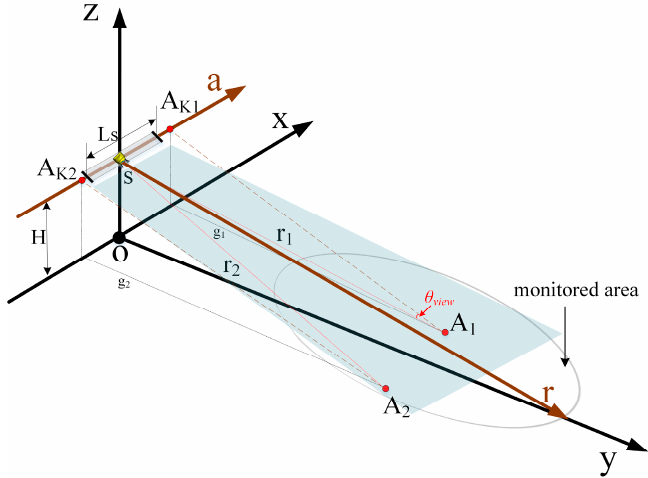
Figure 10. Geometric relationship between GB-SAR and 3D space. A 1 , A 2 correspond to the CRs and s represents the phase center. The origin of the coordinate system was not selected as the location of TLS.